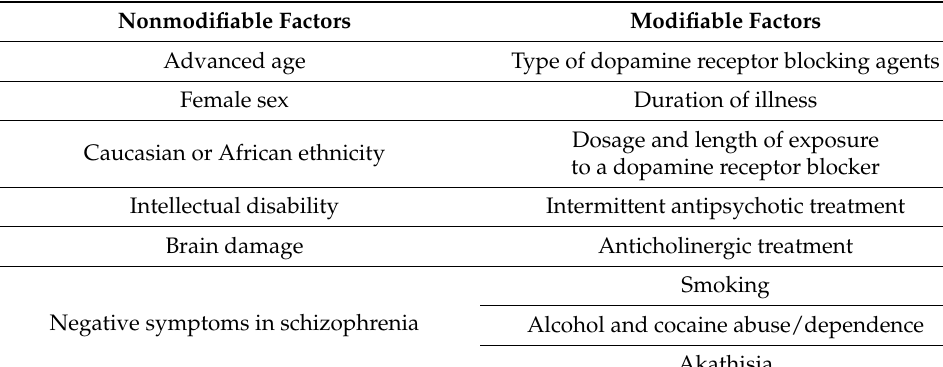
Table 1. Nonmodifiable and modifiable risk factors of